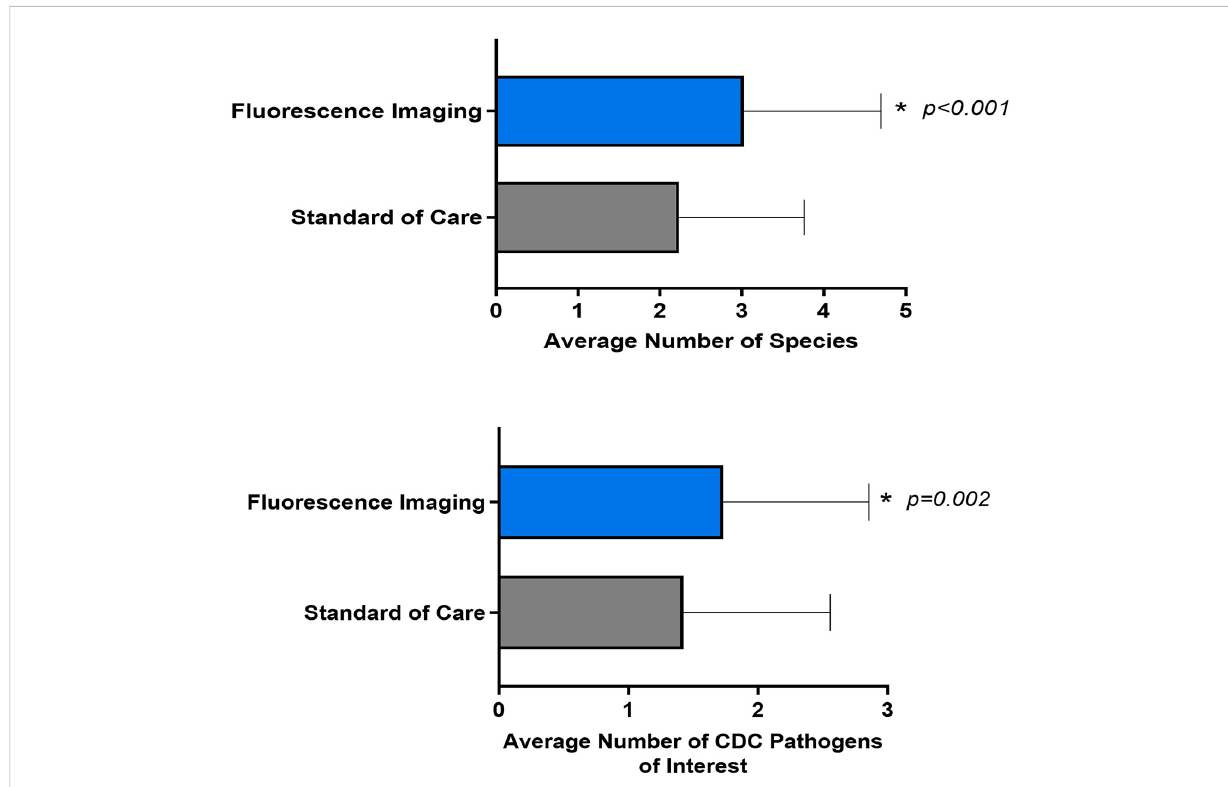
FIGURE 4 Average number of species and CDC pathogens of interest detected by fl uorescence imaging compared to standard of care. Error bars indicate standard deviation. P values are based on paired t-tests.